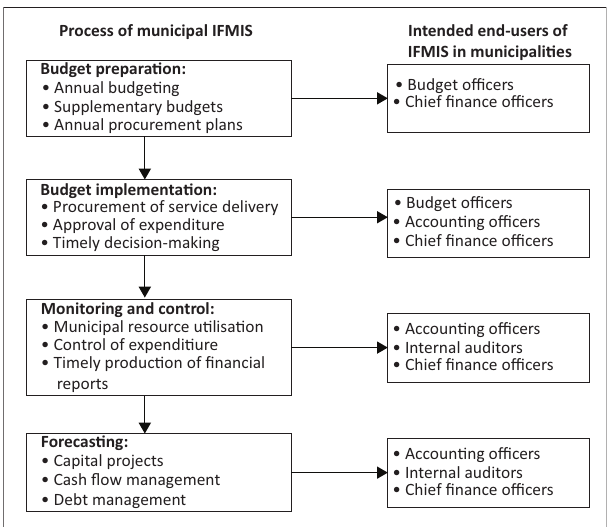
FIGURE 4: The roles of end-users of Integrated Financial Management Information Systems in